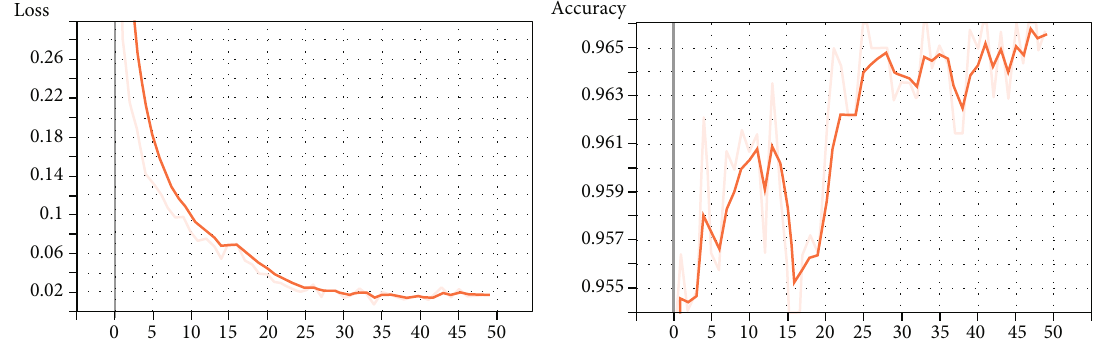
Figure 6: The training loss and test accuracy under the 50% training ratio on the RSSCN7 data